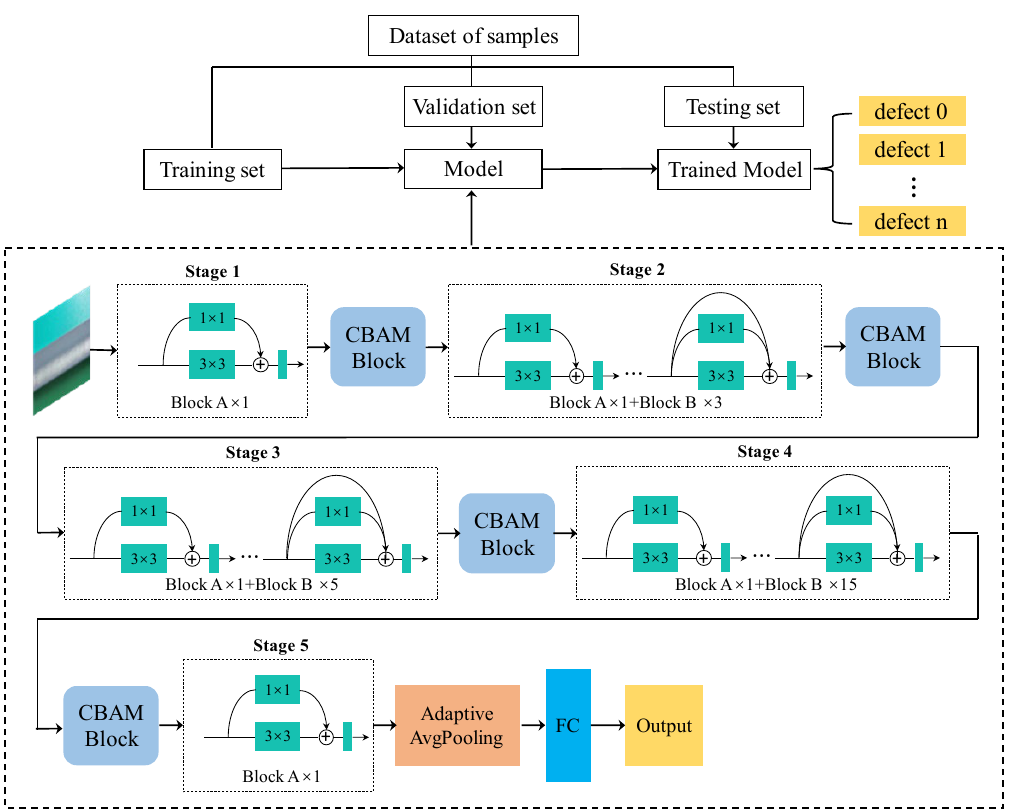
Figure 6. Our method.